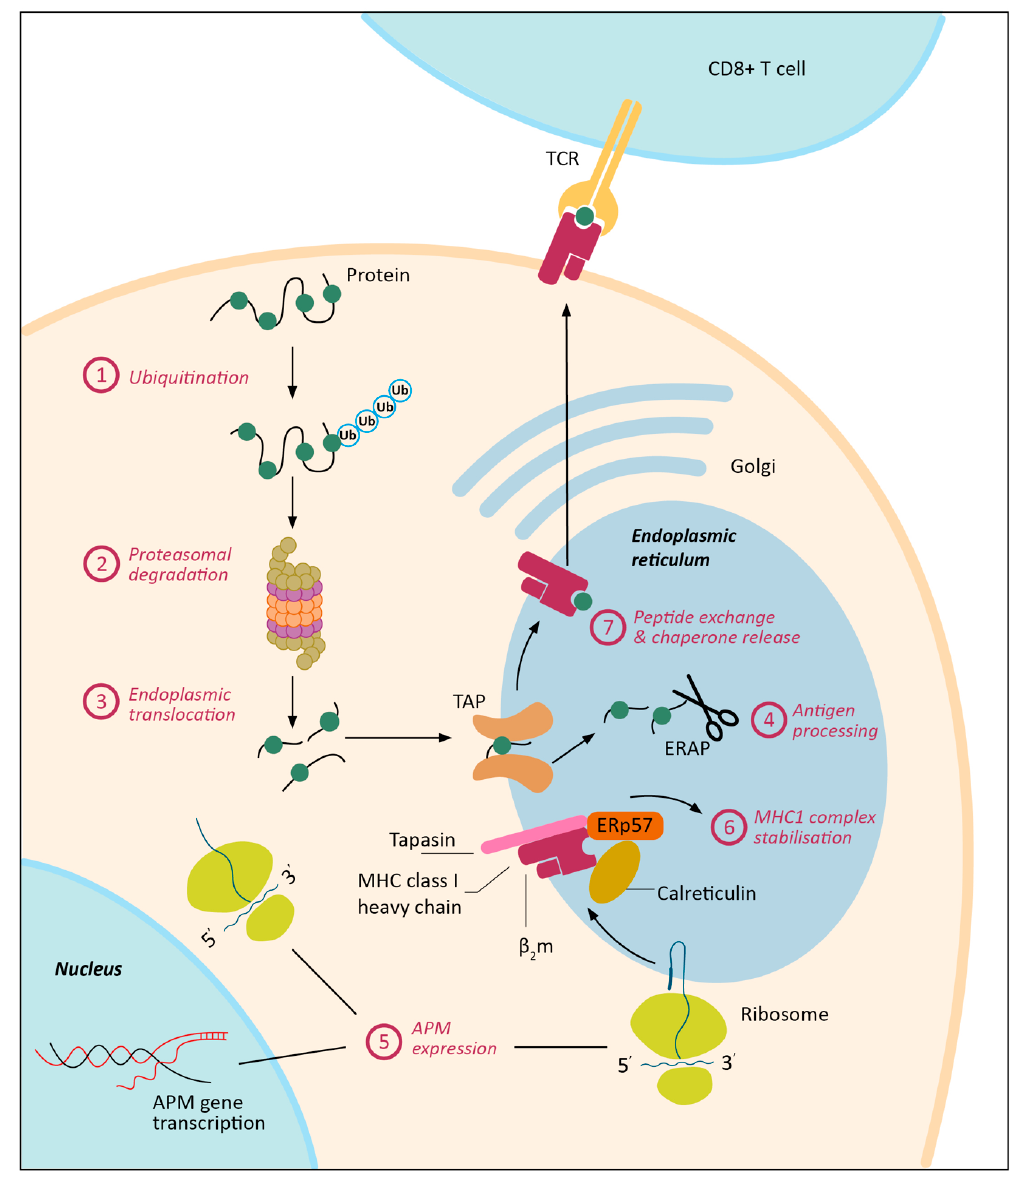
Figure 1. Major histocompatibility complex class I (MHC-I) antigen processing and presentation is a complex, multi-step process and can be dysregulated in cancer at multiple levels. APM = antigen processing machinery; ERAP = ER aminopeptidases; MHC-I = major histocompatibility complex I; TCR = T-cell receptor Dysregulated cell surface display of MHC-I complexes may be caused by genetic, epigenetic, transcriptional, and post-transcriptional alterations, which leads either to irreversible or reversible changes in MHC-I expression. Irreversible MHC-I defects are described in multiple types of cancer, including melanoma, head and neck squamous cell carcinoma (HNSCC), and lung, colorectal, bladder, laryngeal, and breast cancer [9,12–17] and arise due to structural genetic alterations, for example, in the class I heavy chain genes [12–14], β 2 M [9,15,16], and the TAP-encoding genes [17]. As